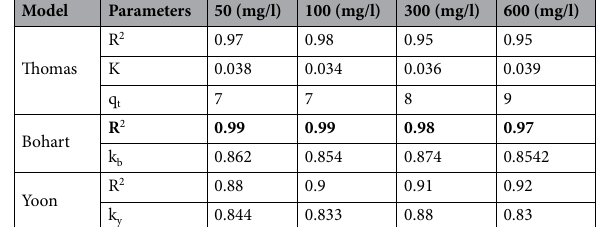
Table 6. Summary of the experiments obtained with material EC-Na. Significance values are in bold.